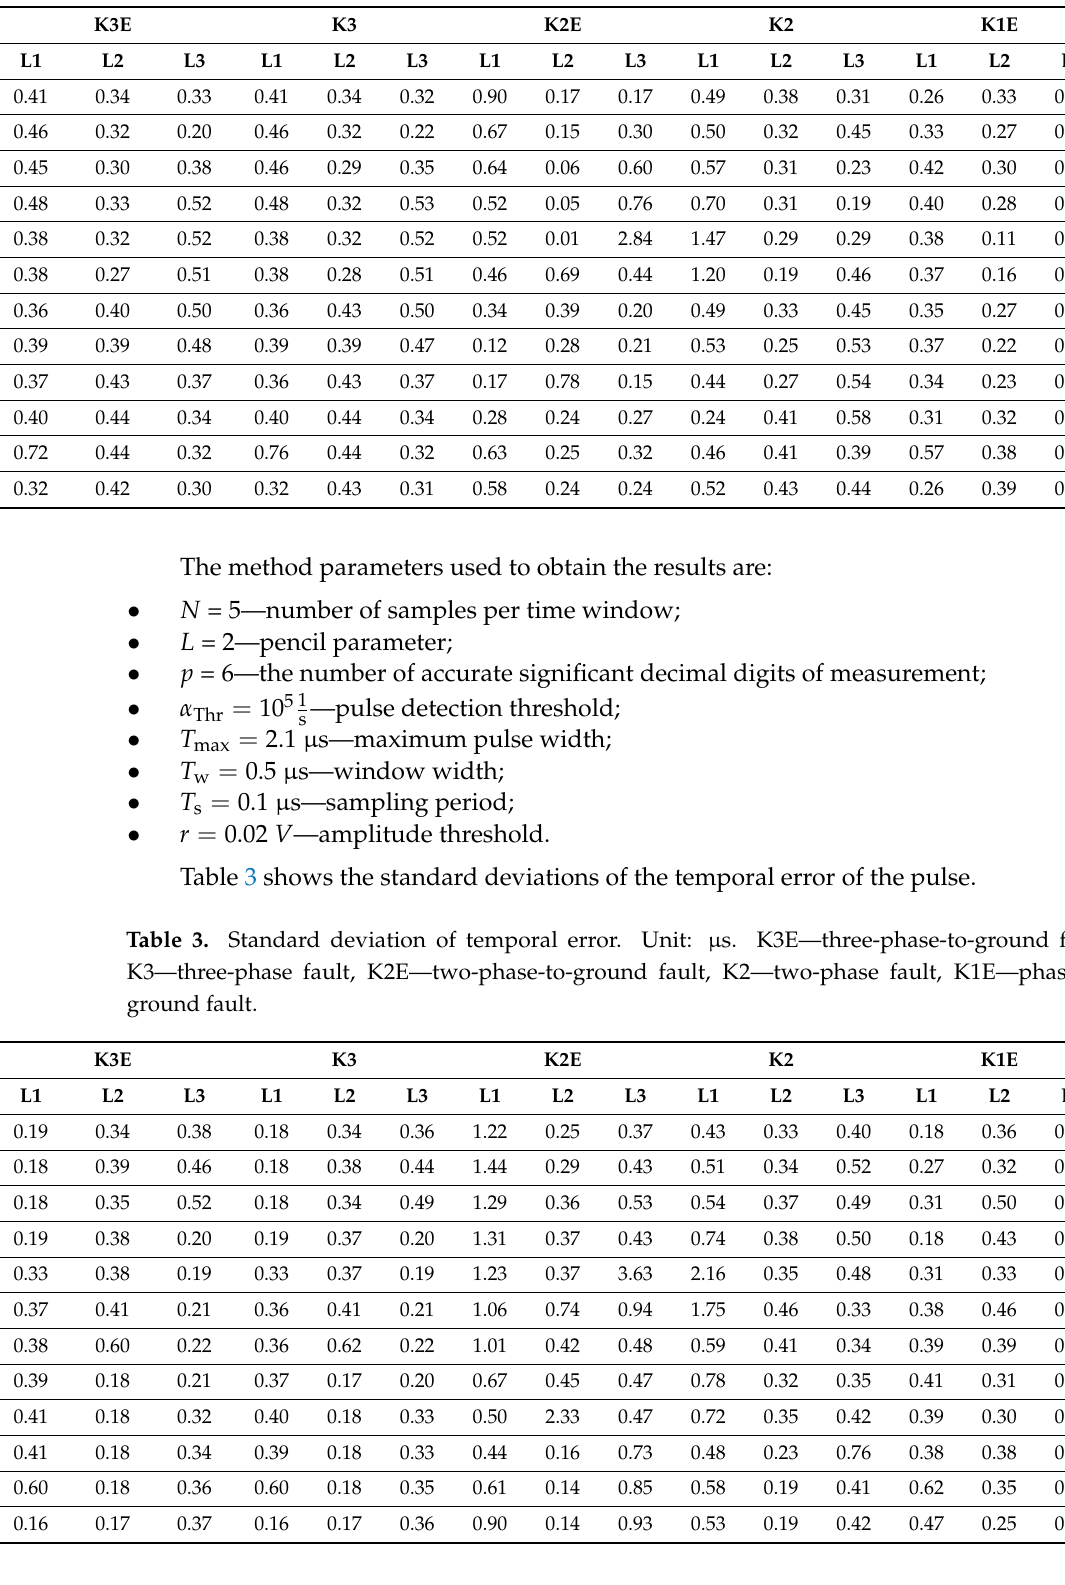
Table 2. Temporal error of wave identification in case of different faults. Unit: µ s. K3E—three- phase-to-ground fault, K3—three-phase fault, K2E—two-phase-to-ground fault, K2—two-phase fault, K1E—phase-to-ground fault.